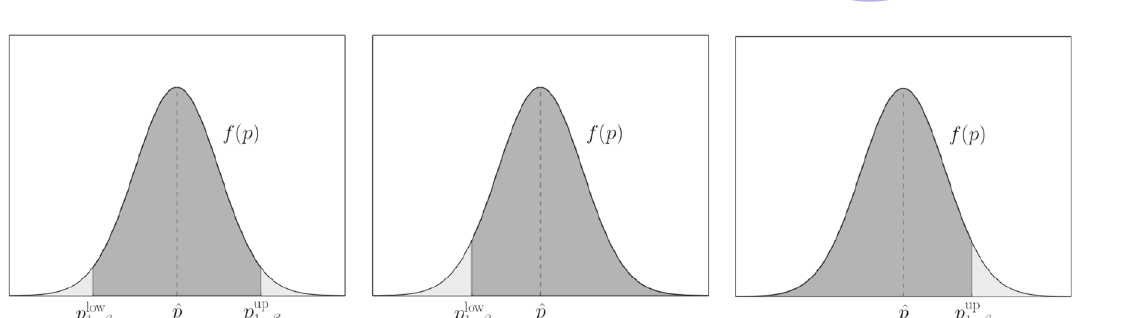
Fig. 4 Illustration of a two-sided confidence interval (left panel), a one-sided confidence interval with a lower bound (middle panel) and a one-sided confidence interval with an upper bound (right panel), for a given probability density function f ( p ) of a parameter